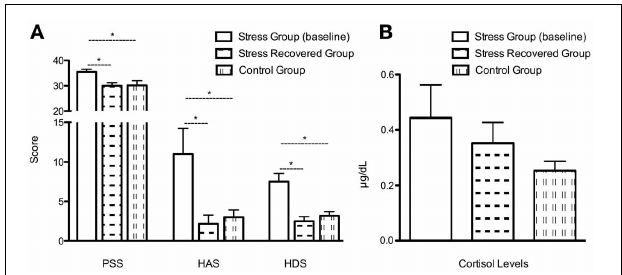
FIGURE 1 | Clinical characteristics of the cohort. (A) Perceived Stress Scale (PSS), Hamilton Anxiety Scale (HAS); Hamilton Depression Scale (HAD) and (B) Salivary Cortisol levels in the two groups (stress, stress recovered, and control group); ∗ P < 0 .